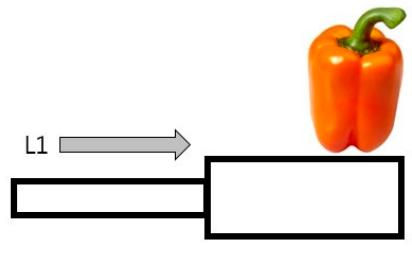
Figure 11. Approaching sequence.